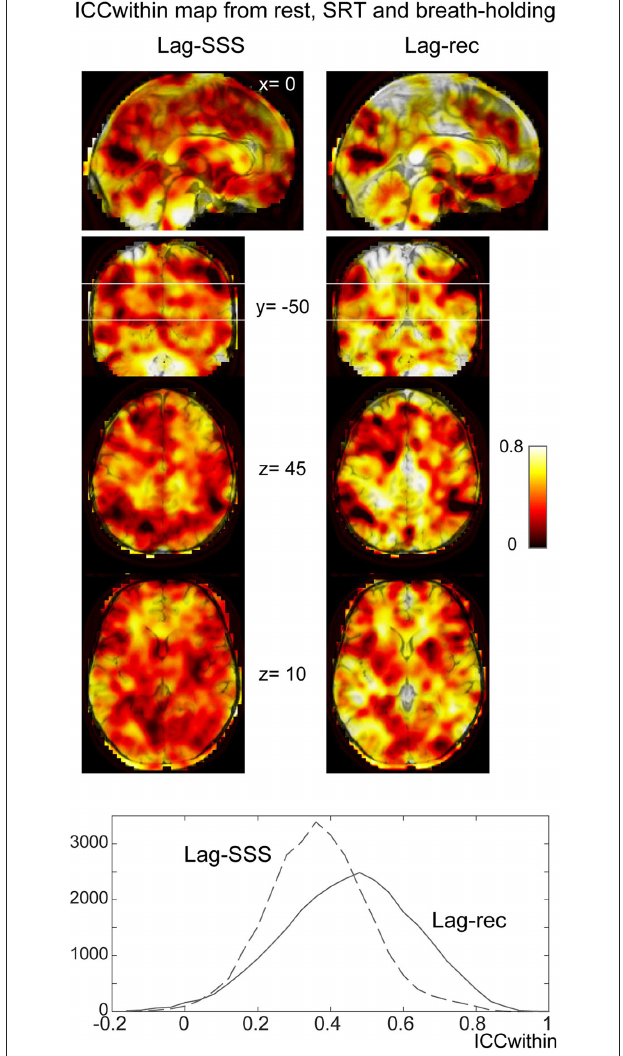
FIGURE 7 | Within-voxel reproducibility from the breath holding experiment. ICC within was calculated using the three runs: rest, SRT task, and breath-holding. It is clear from the maps and the image histogram that reliability of the Lag-rec map was superior to the Lag-SSS, although they shared some spots of poor